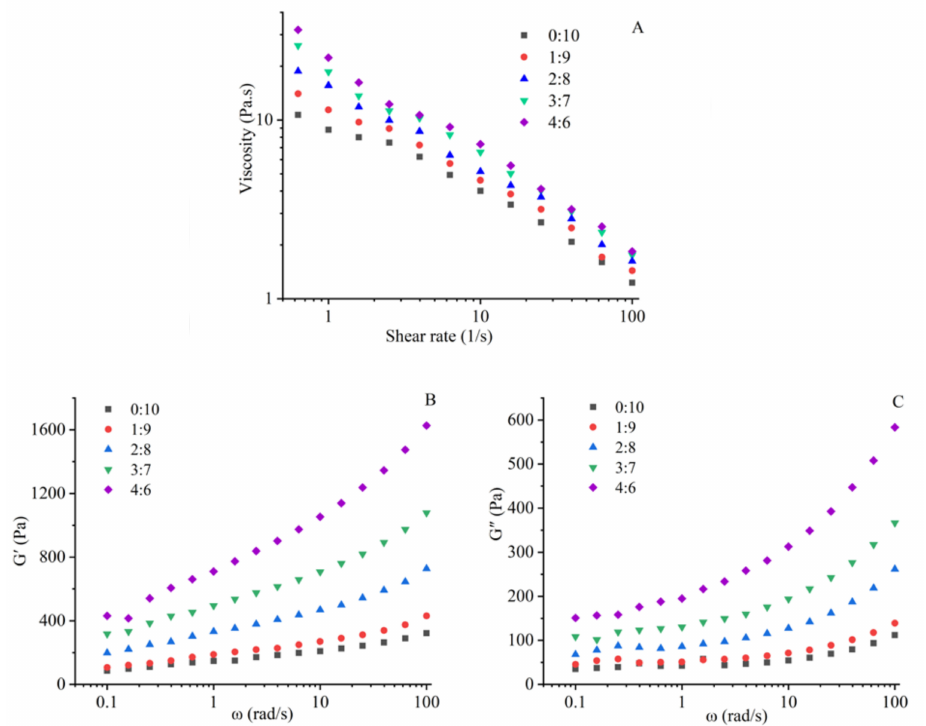
Figure 1. Rheological properties of the mixed raw materials with different surimi to soybean flour ratio. ( A ) the relationship of shear stress and apparent viscosity; ( B ) variation of storage modulus (G (cid:48) ); ( C ) variation of loss modulus (G (cid:48)(cid:48)